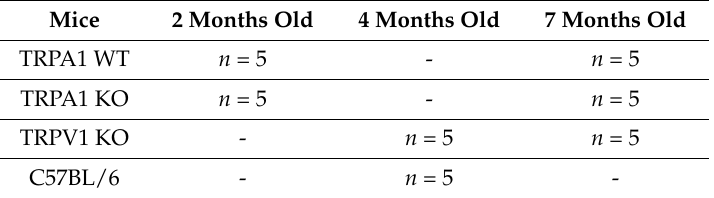
Table 4. Mouse spines used for FAST